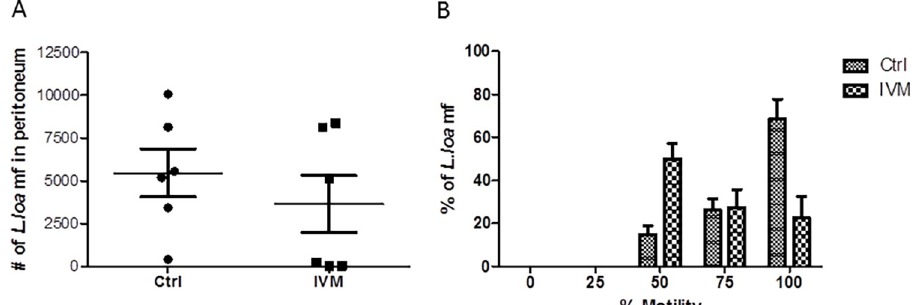
Fig 4. Ivermectin reduces L . loa mf viability in gerbils. Each of 12 animals (males and females) was infected intraperitoneally with 16,000 isolated L . loa mf and 6 of them were treated with 150 μ g/kg body weight IVM by oral gavage on day 7. Control animals received vehicle (1% DMSO in PBS). Animals were sacrificed on 30 days post- infection and analyzed for mf. (A) Number of L . loa mf recovered from the peritoneum. (B) Proportion of L . loa mf from the animal peritoneum at different percent motility.